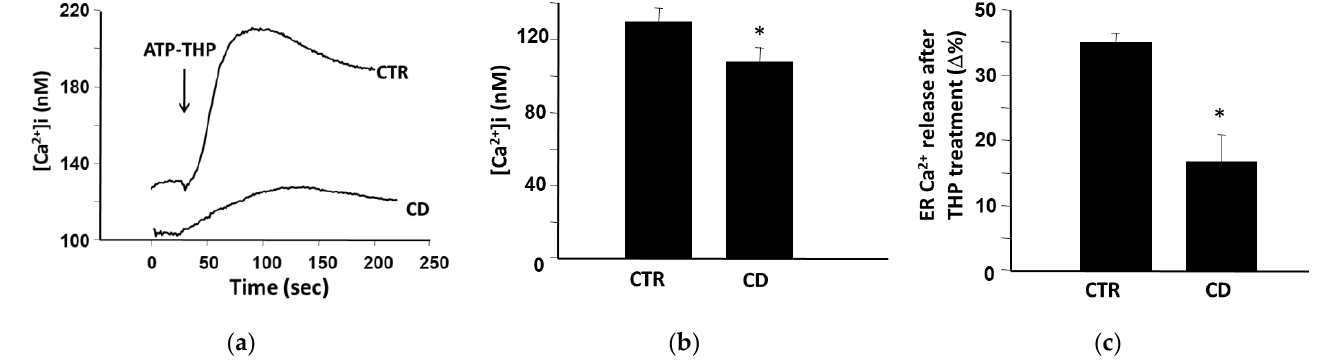
Figure 1. Relative cell viability measured by an MTT assay after treatments with THP ranging from 0.01 to 1 µM (for 24 h) or from 0.01 to 0.5 µM (for 48 and 72 h). Basal viability is measured in the presence of the vehicle (DMSO 0.05%). In all experiments, the vehicle reduced cell viability by no more than 10–15%. Data are reported as means ± standard error (SE) from two independent experiments, each performed in triplicate, on three non-CD cultures and three CD cultures. * p < 0.05 versus the respective vehicle.